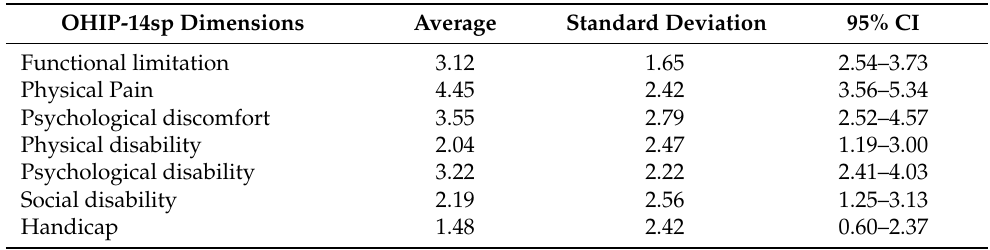
Table 4. Averages and standard deviation of OHP-14sp score in each